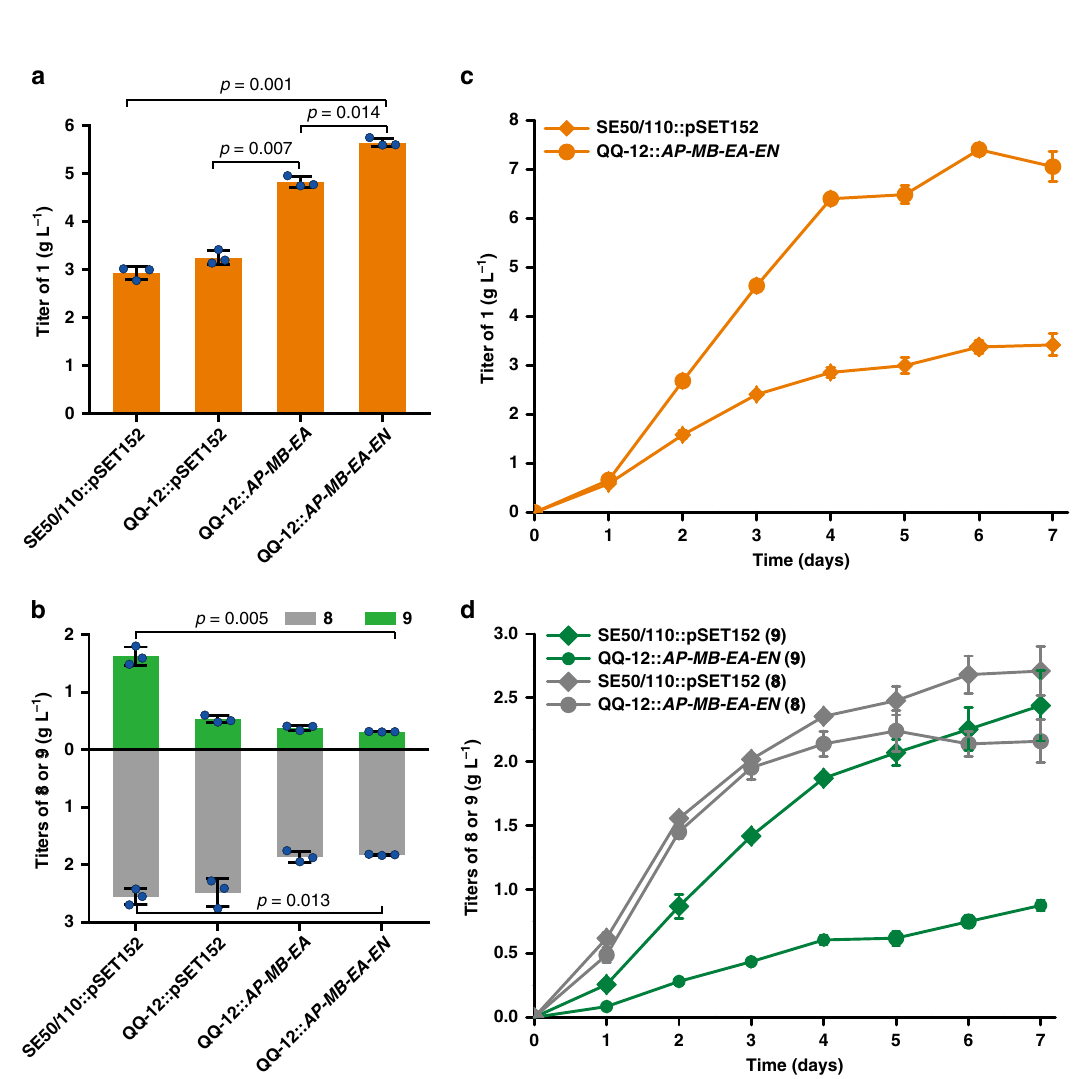
Fig. 7 Integration of the effective engineering strategies. a , b The titers of 1 , 8 , and 9 of SE50/110::pSET152 (as a control), QQ-12::pSET152 (as a control), and QQ-12:: AP-MB-EA and QQ-12:: AP-MB-EA-AN after fermentation for 4 days. Two-tailed paired t tests. c , d Fed-batch fermentation of SE50/110:: pSET152 (rhombus) and QQ-12:: AP-MB-EA-AN (circle). Time courses of 1 (orange), 8 (gray), and 9 (green) titers were monitored. Error bars, mean ± SD ( n = 3 biological replicates). For more details, see also Supplementary Fig. 47. Source data are provided as a Source Data fi 17.0% when AN was introduced (Fig. 7a, b; Supplementary Fig. 47). The best engineered strain, QQ-12:: AP - MB-EA - AN , produced 7.4 g L − 1 of 1 in 6-day fed-batch fermentation, repre- senting a 1.2-fold titer and 2.3-fold productivity improvement of 1 , a 20.2% decrease of 8 , and a 67.1% decrease of 9 (Fig. 7c, d). However, an unexpected 33.0% decrease in biomass occurred when compared with the control strain SE50/110::pSET152 (Supplementary Fig. 47c).